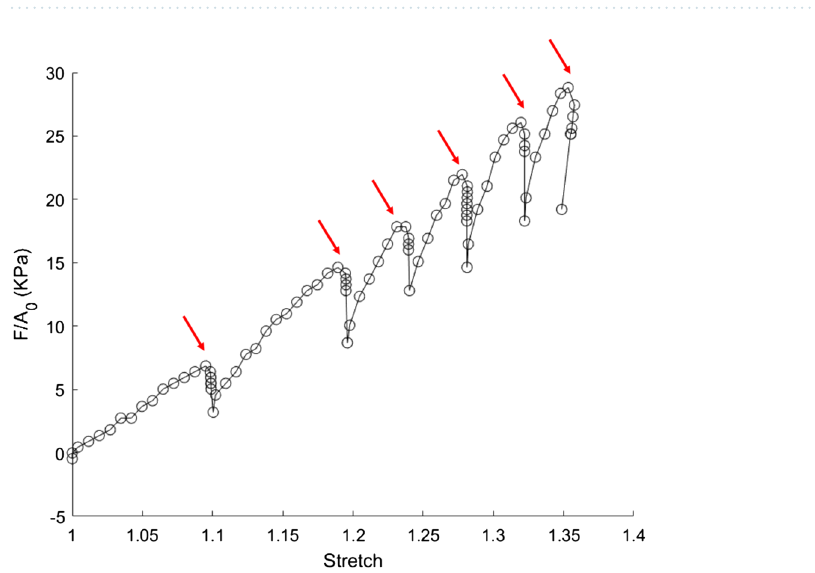
Figure 2. Comparison between ( a ) white-light images and ( b ) azimuth (in ◦ ) maps. ( c ) α histogram of two samples.